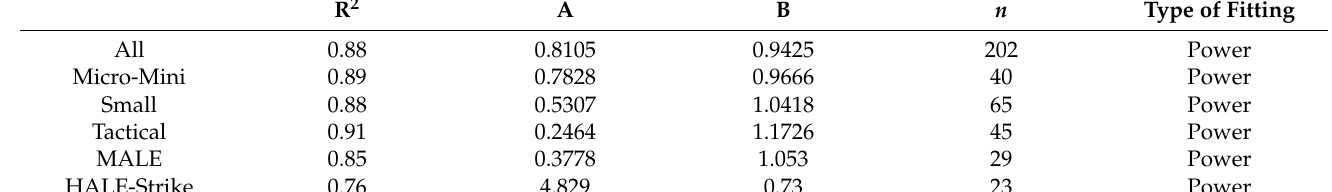
Figure 12. Empty weight as a function of GTOW with respect to NATO classification. The color code is identical to the one described in Figure 6. Table 7. Statistical data regarding the trend fitting for the empty weight as a function of GTOW plots.